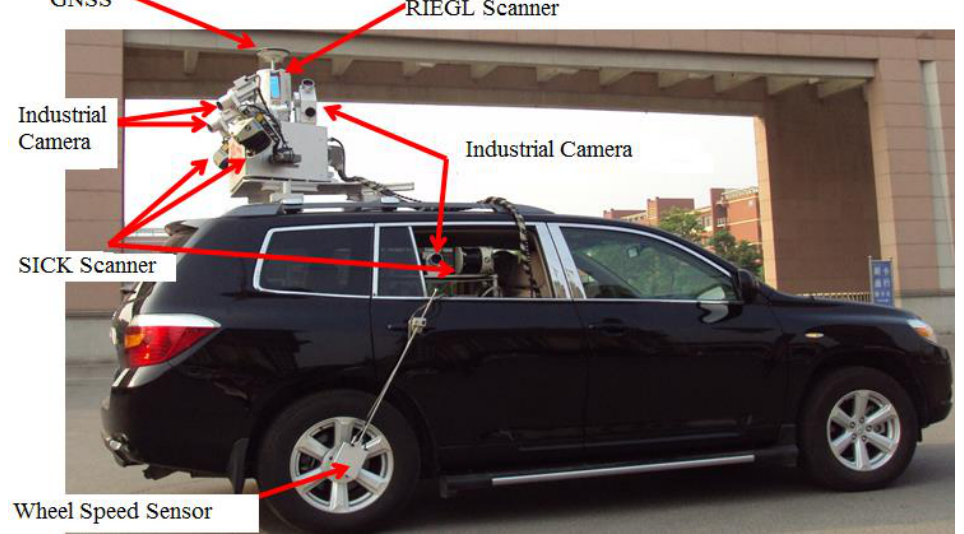
Figure 7. Vehicle-borne surveying system.